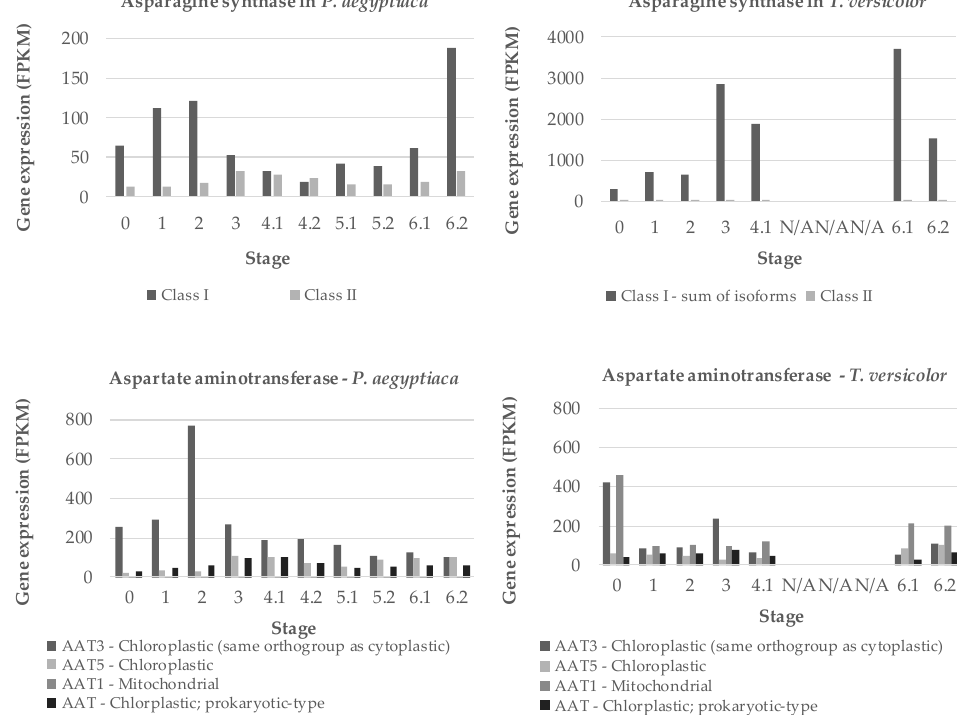
Figure 8. Expression of two amino acid metabolism genes. Gene expression of asparagine synthases (AS) class I and II and aspartate amino transferases (AAT) enzymes is shown for the obligate holoparasite P. aegyptiaca and facultative hemiparasite T. versicolor . Gene expression is shown in fragments per kilobase million (FPKM). Stages 5.1 and 5.2 represent shoots and roots, respectively, harvested before the parasite emerges from the soil. Stages 6.1 and 6.2 represent above-ground vegetative tissue and floral buds, respectively, after the parasite emerges from the soil. FPKM levels for P. aegyptiaca AAT5 and AAT1 and T. versicolor AAT3 and AAT1 are the sums of the FPKM levels for two or more bioinformatically identified isoforms of the same gene. The gene expression data are from previous study through the Parasitic Plant Genome Project [21], and contigs used are presented in Table S2.